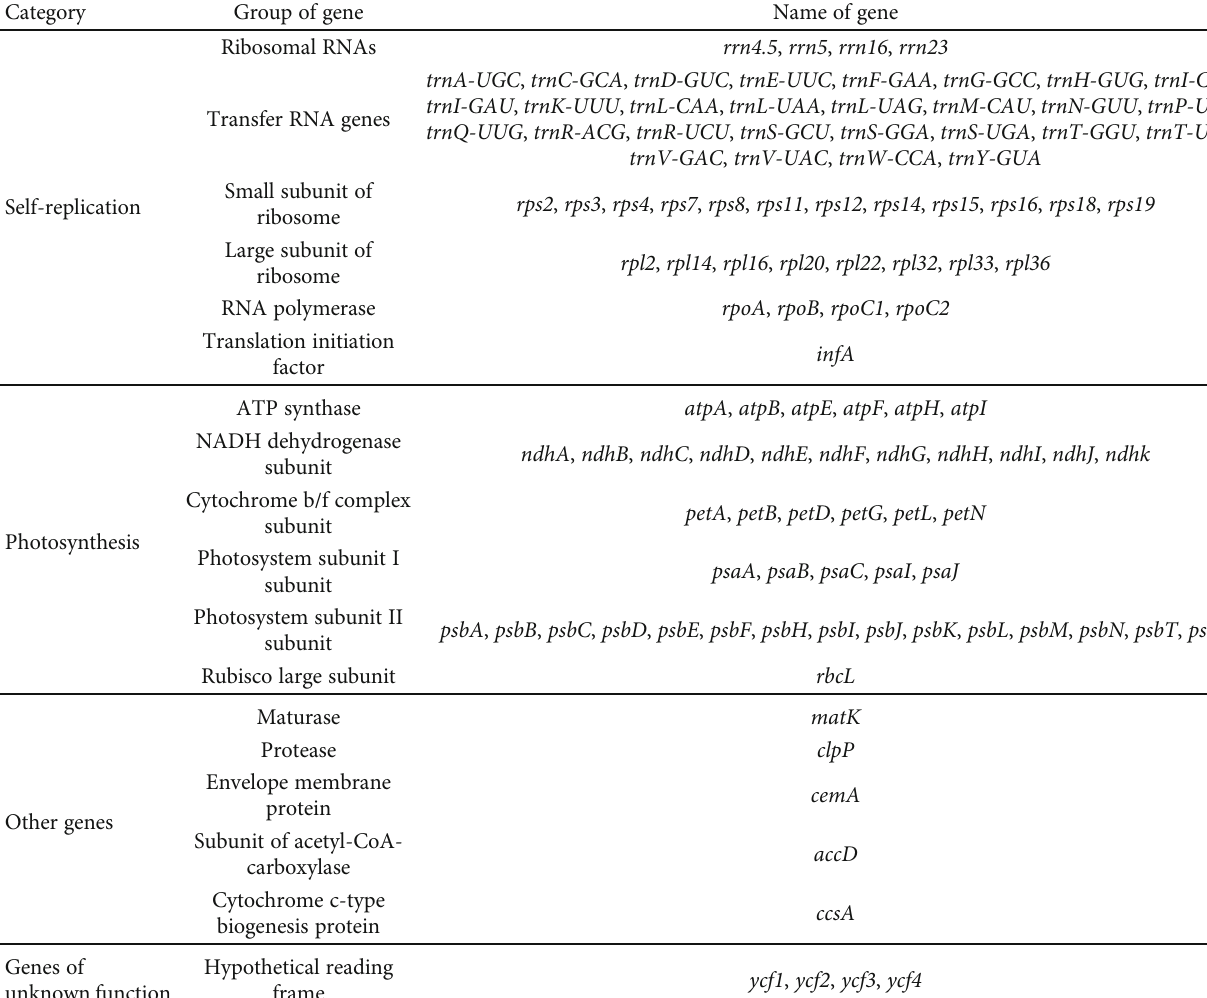
Table 4: List of genes encoded by Chenopodium album chloroplast